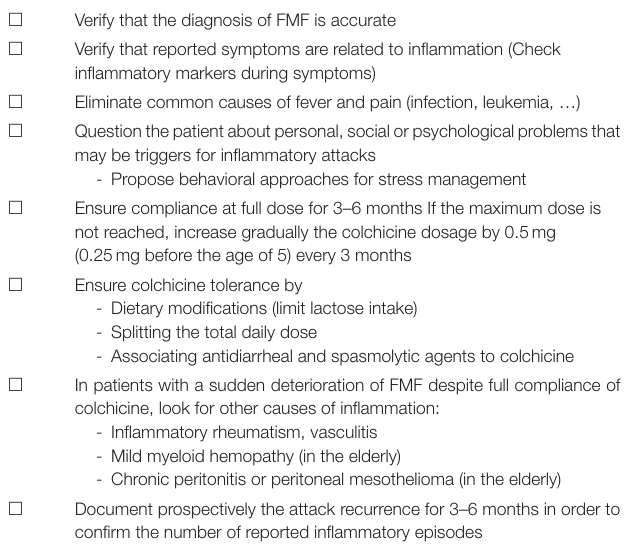
TABLE 2 | Check list before considering colchicine